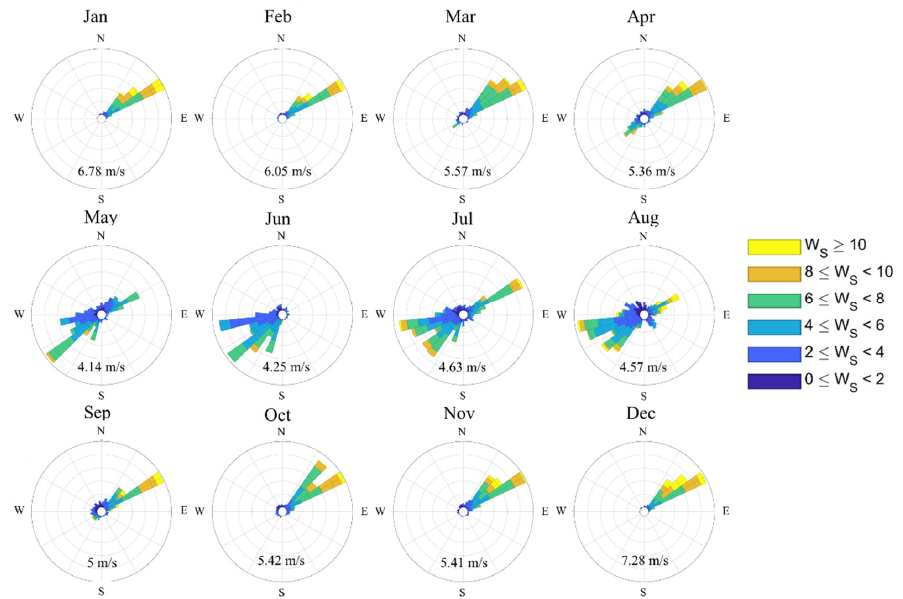
Figure 8. Monthly wind rose diagrams of East Asian monsoons derived from statistical wind data (https://cbw.gov.tw (accessed on 23 February 2021)) are exhibited from January to December in 2015.